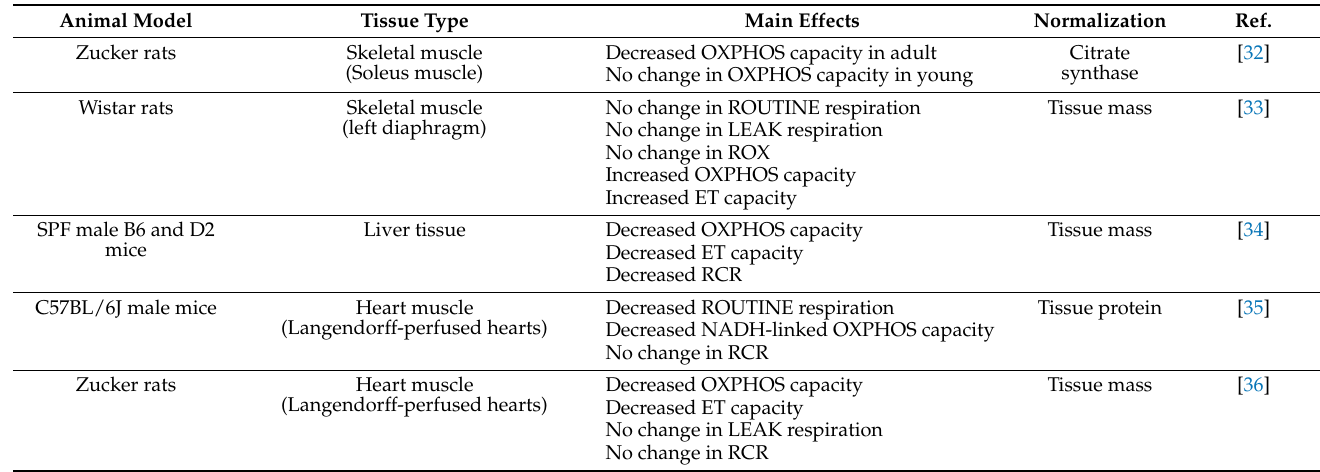
Table 2. High-resolution respirometry findings in animal obesity